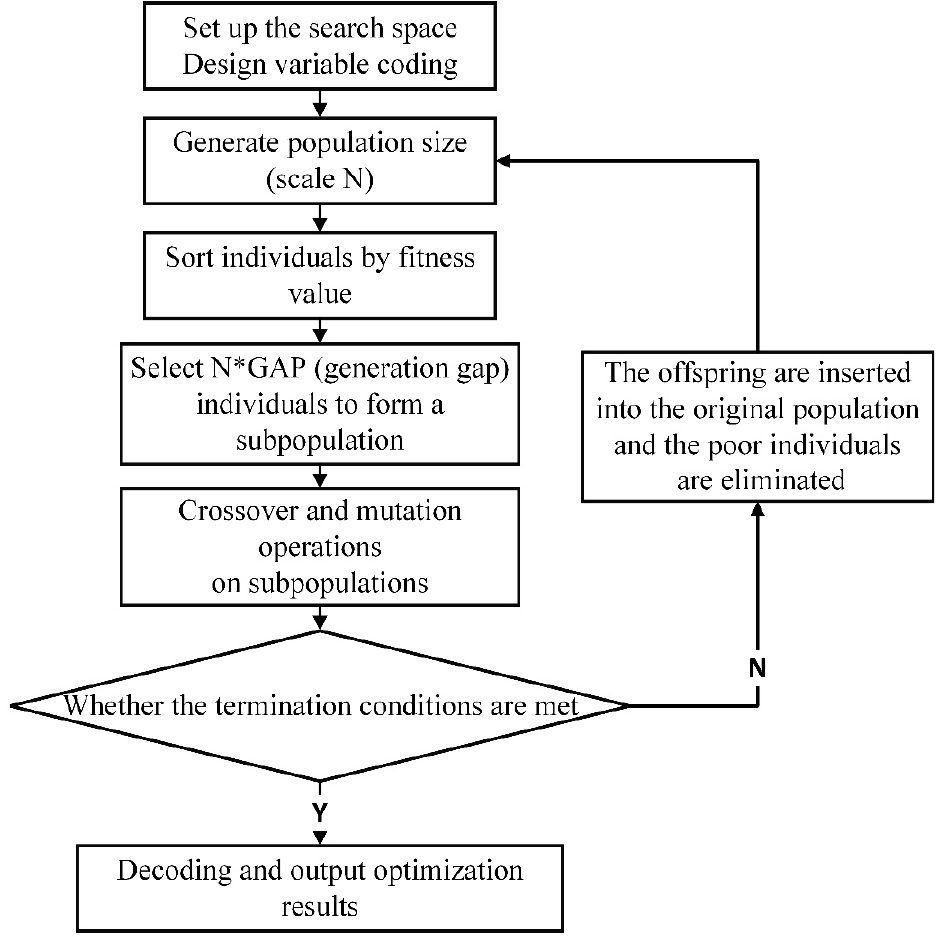
Figure 10. Operational steps in genetic algorithm design.